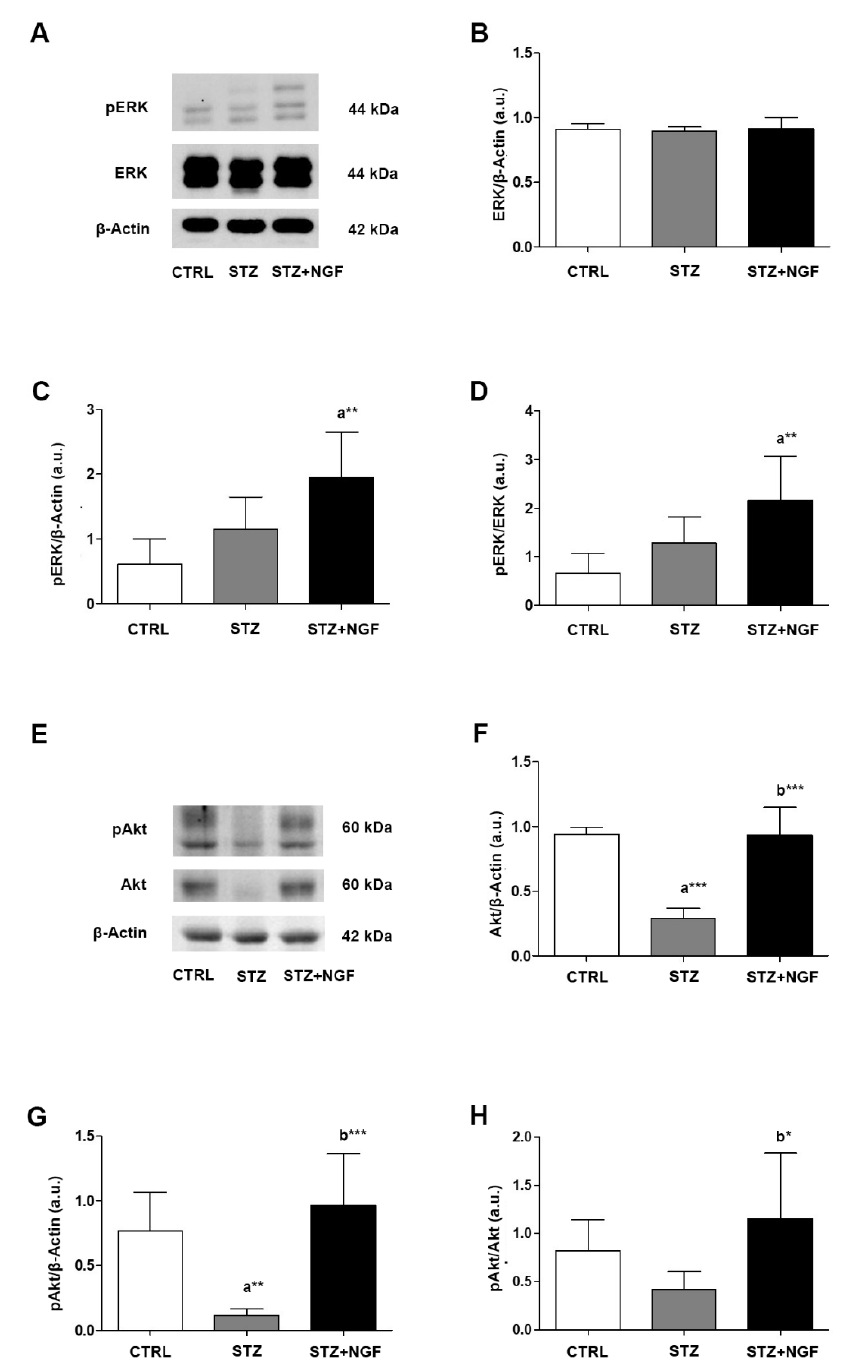
Figure 8. ( A – H ). Levels of signaling mediators ERK and Akt in diabetic retinas before and after ocular NGF treatment. ERK and Akt, and their phosphorylation statuses (pERK and pAkt, respectively) levels were affected by diabetes (STZ) and ocular NGF treatment (STZ+NGF). The effects are visible in the representative Western Blots ( A , E ) and densitometric analyses ( B – D , F – H ). β -Actin expression was used to normalize sample variability, a.u. indicates arbitrary units. The results are expressed as mean ± SD. * p < 0.05, ** p < 0.01, *** p < 0.001. “a” vs. CTRL group; “b” vs. STZ group. CTRL, healthy rats; STZ, streptozotocin; STZ+NGF, streptozotocin+nerve growth factor eye drops. In contrast to ERK signaling, total Akt and phosphorylated Akt (pAkt) levels (Figure 8E–G) were reduced following STZ induction when compared to CTRL ( p < 0.001 and p <